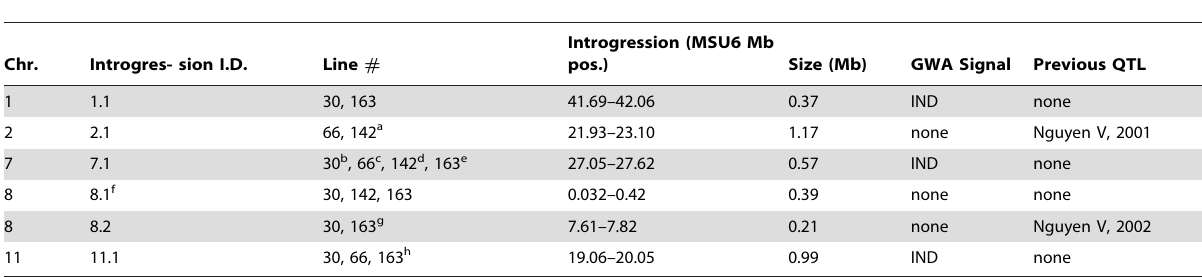
Table 3. Summary of Japonica introgressions in the Indica outliers.